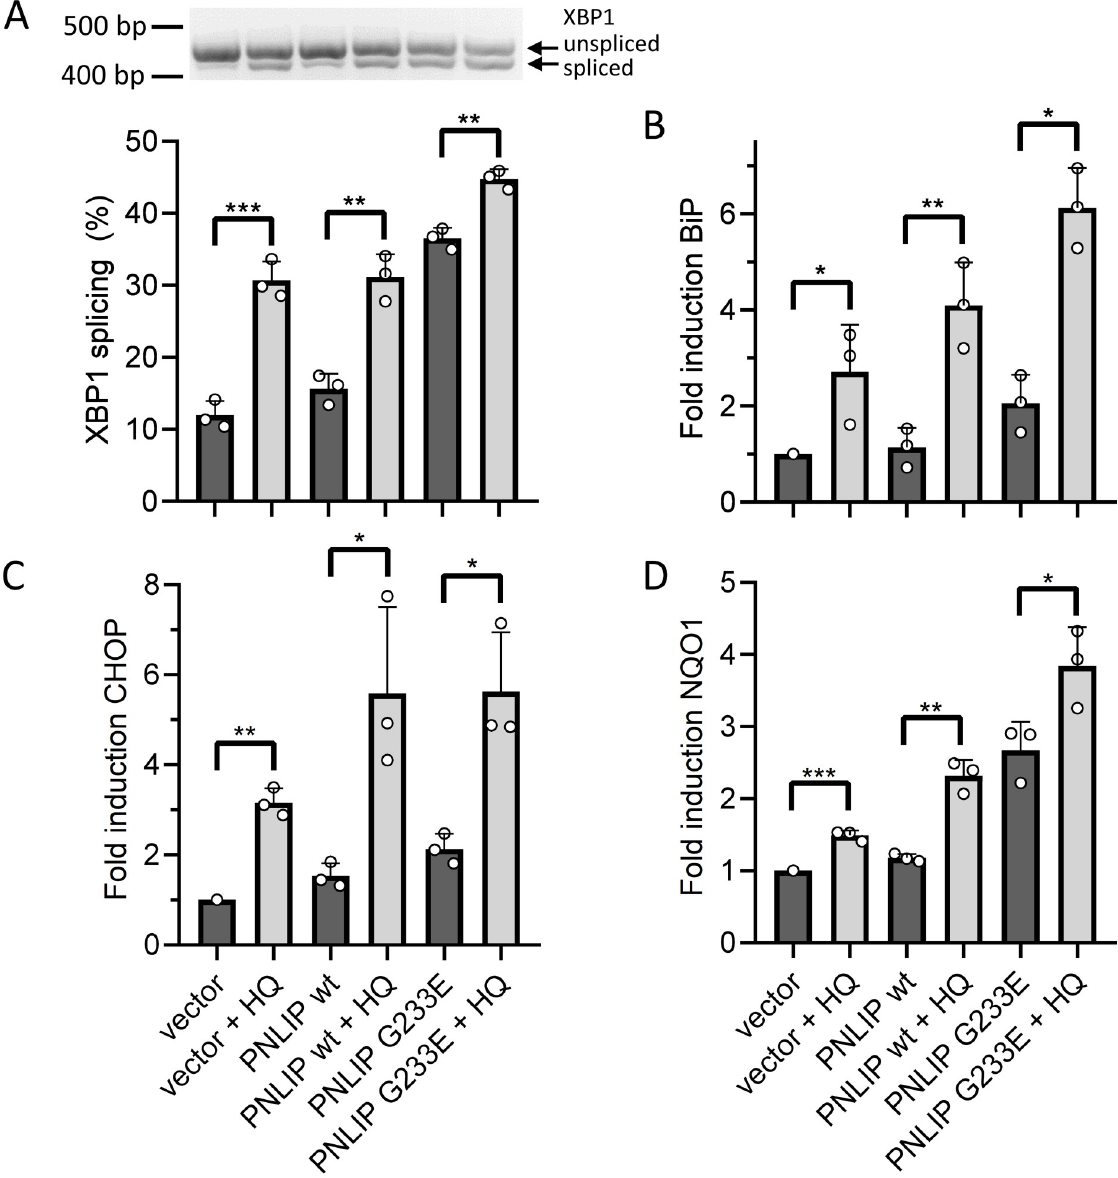
Fig 8. Effect of hydroquinone (HQ) on the levels of ER stress markers in wild-type and G233E mutant PNLIP expressing AR42J cells. One day post-transduction, cells were incubated in the absence or presence of 40 μ M HQ for 24 h at 37 ˚C. The mRNA levels of A) XBP1 splicing, B) BiP, C) CHOP and D) NQO1 expressions were assessed as described in Materials and Methods. Cells infected with empty adenovirus vector were used as control. Data points represent the average of three independent experiments with SD. � P � 0.05; �� P � 0.01; ��� P �